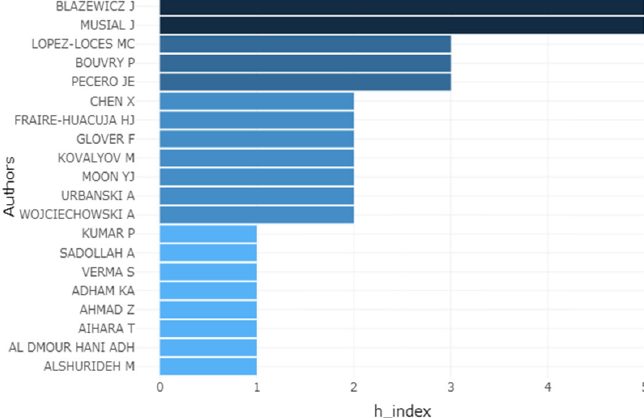
Fig. 7. Author Impact Based on